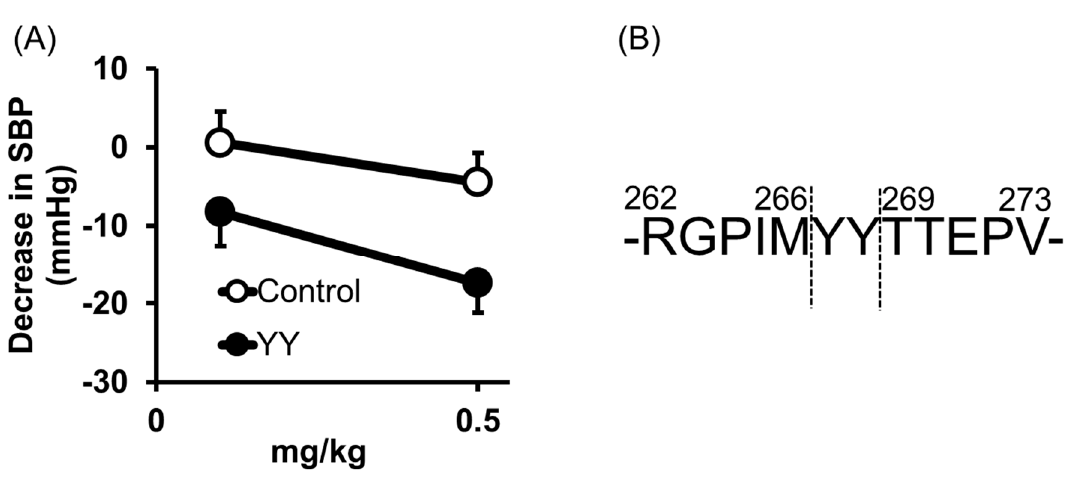
Figure 4. Predicted cleavage site of LRA from vicilin-like storage protein. These figures were modified and quoted from those previously reported by the author [26].